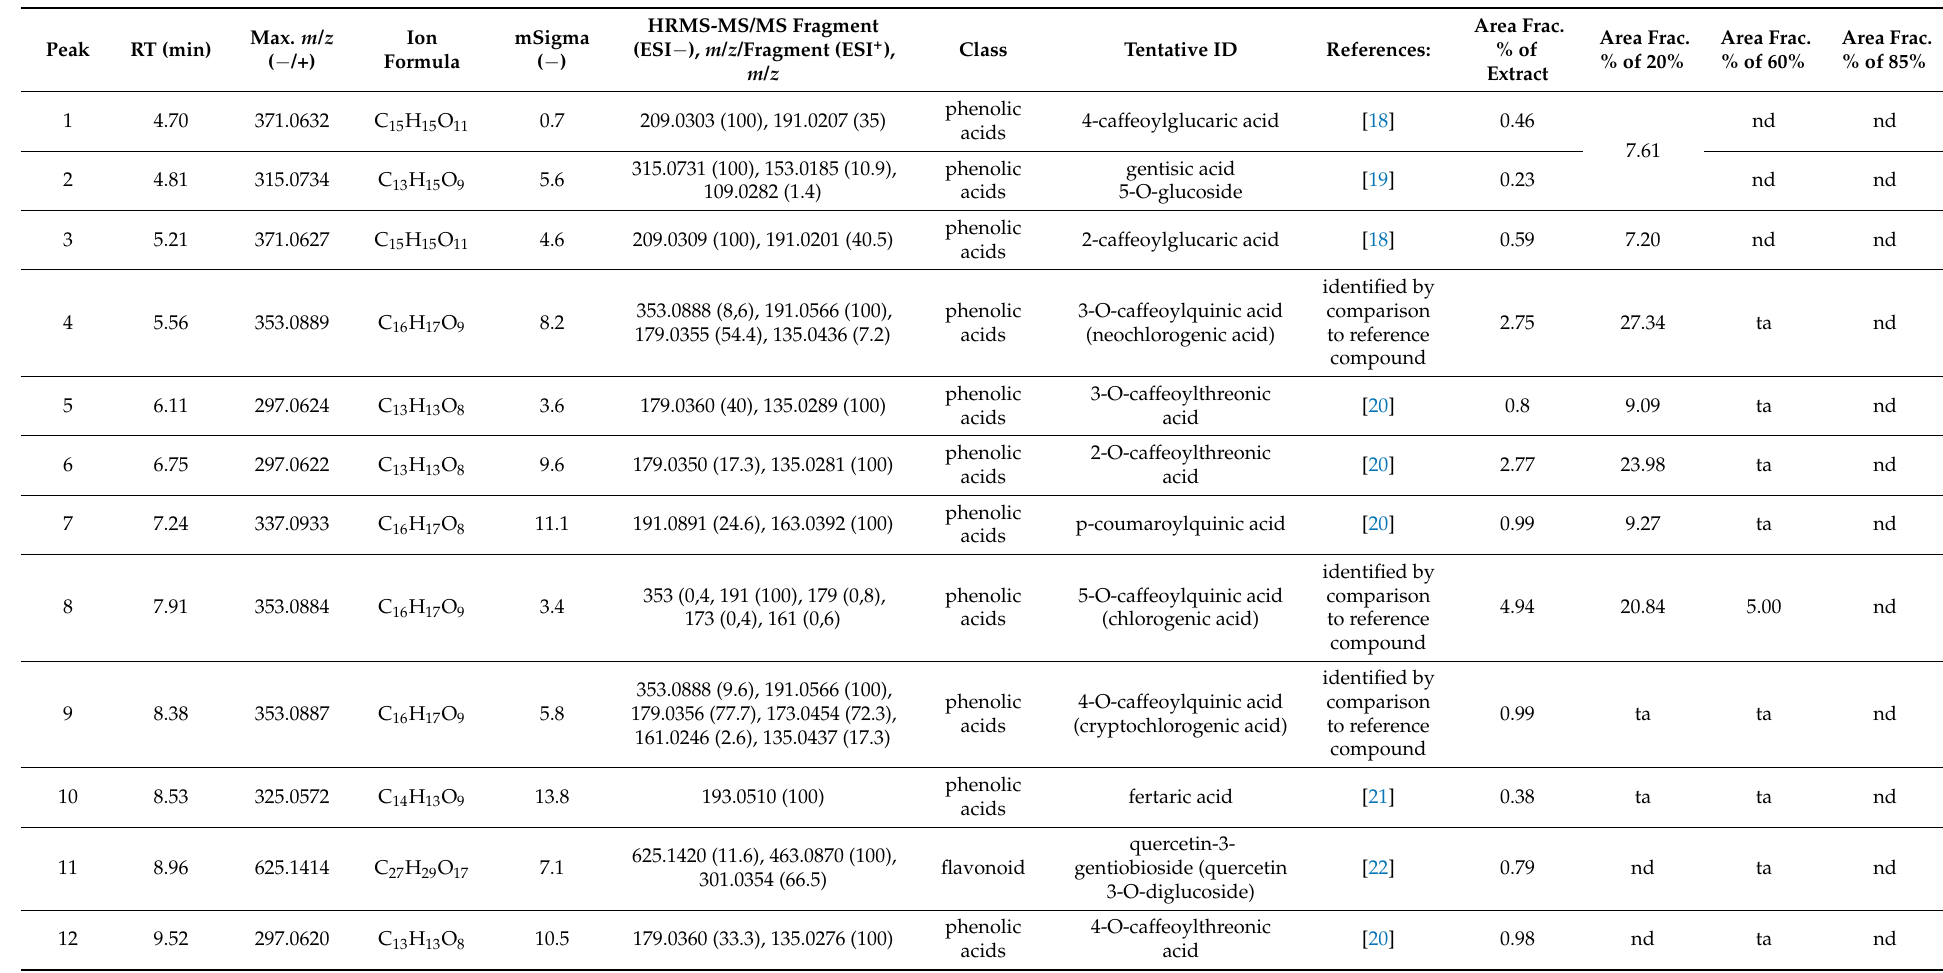
Table 1. Phytochemical characteristics of the crude extract and three fractions (20%, 60%, and 85%) from G. hederacea identified by UHPLC-QTOF